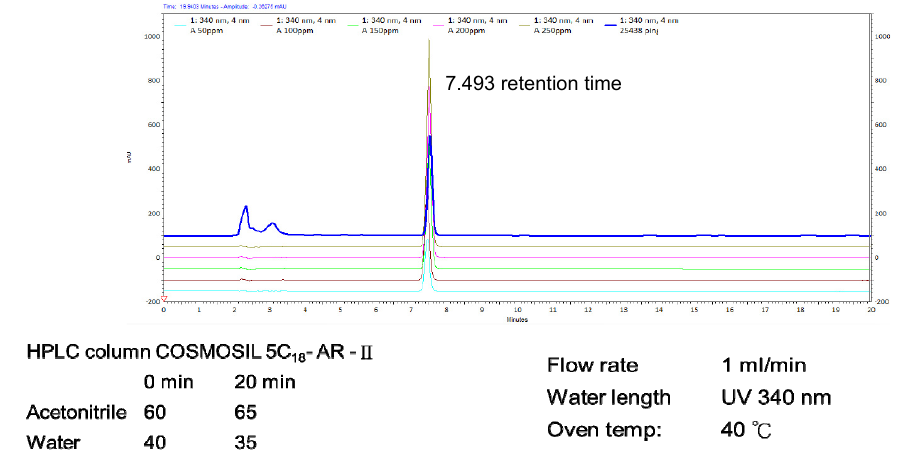
Figure 1. HPLC analysis and LC-MS analysis of the ethanol Hericium erinaceus mycelium (HEM) extract. The retention time peak at 7.493 min was erinacine A (UV detection at 340